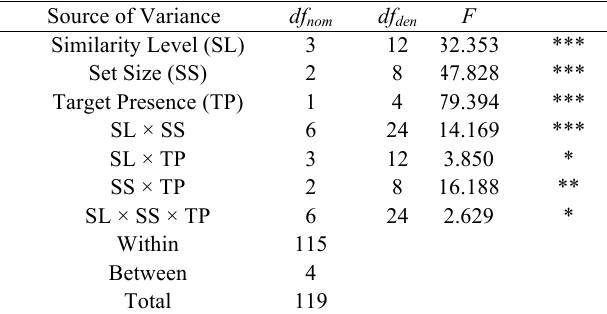
Three-way repeated measures analysis of variance for reaction time.